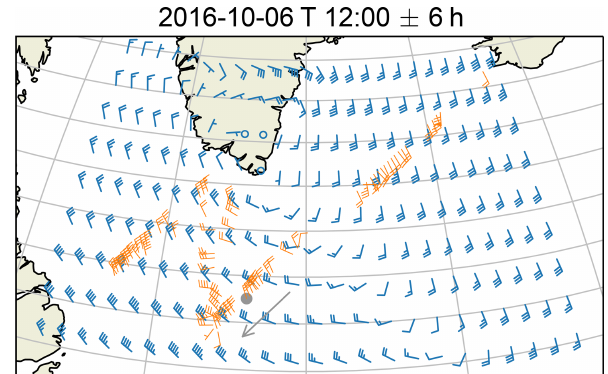
Figure 7. Horizontal wind at about 2000m above ground. Compar- ison between ECMWF reanalysis (blue) and stereo-derived wind (orange). Comparing grid points with co-located stereo data, the mean horizontal wind magnitude is 15 . 1ms − 1 in ECMWF and 13 . 4ms − 1 in the stereo dataset. This amounts to a difference of 1 . 7 ± 4 . 5ms − 1 in magnitude and 6 . 0 ± 33 ◦ in direction. The shown deviations are standard deviations over all grid points with co- located data. The gray dot and arrow mark the location and flight course corresponding to Fig.